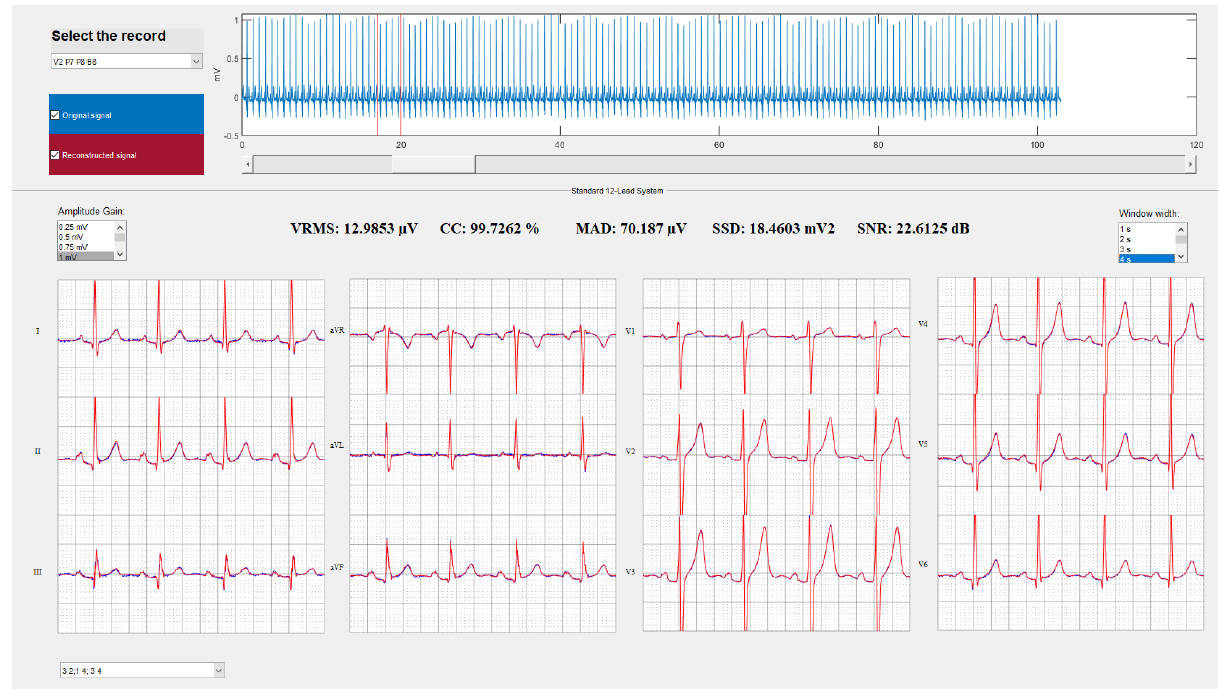
Figure 9. Reconstruction of the Standard 12-Lead System applying the 12-output ANN-based algorithm for the set of electrodes and leads chosen as the best option. First position was obtained by electrodes V2, P7, P8 and B8; arranged in leads P8-P7, V2-B8 and P8-B8. The original 12 leads are represented in blue, and the 12 reconstructed leads are superimposed in